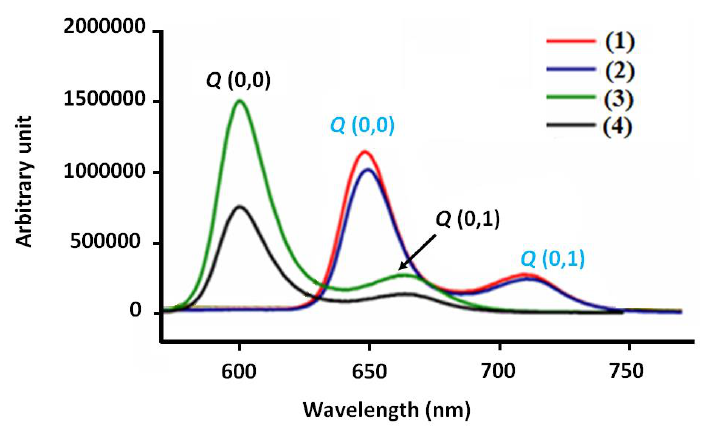
Figure 2. Emission spectra of compounds ( 1 ) – ( 4 ). The spectra were recorded in dichloromethane at concentrations ~10 − 6 M. The excitation wavelength value was 430 concentrations ~10 −6 M. The excitation wavelength value was 430 nm.